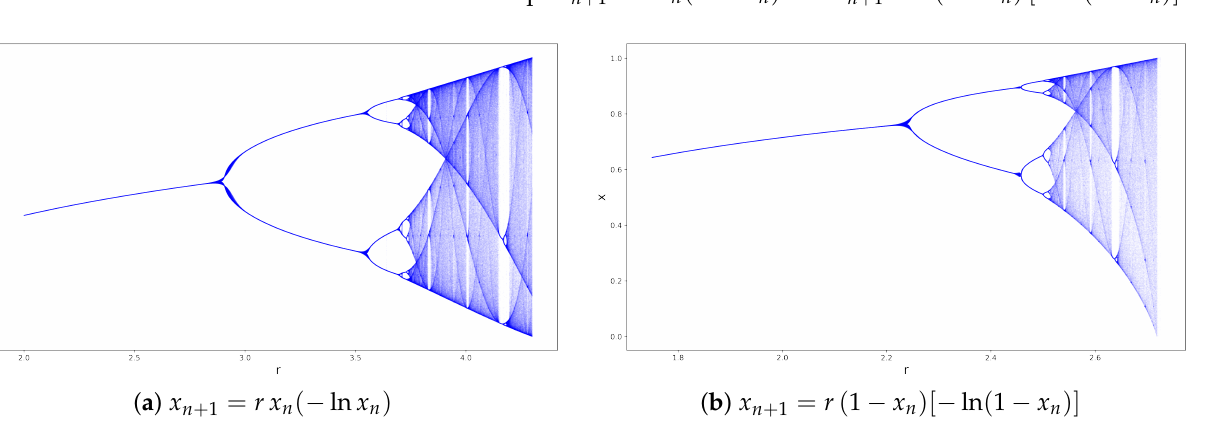
Figure 12. Bifurcation diagrams for the Gompertz map x n + 1 = r x n ( − ln x n ) (Gumbel) and for the modified Gompertz map x n + 1 = r ( 1 − x n )[ − ln ( 1 − x n )]